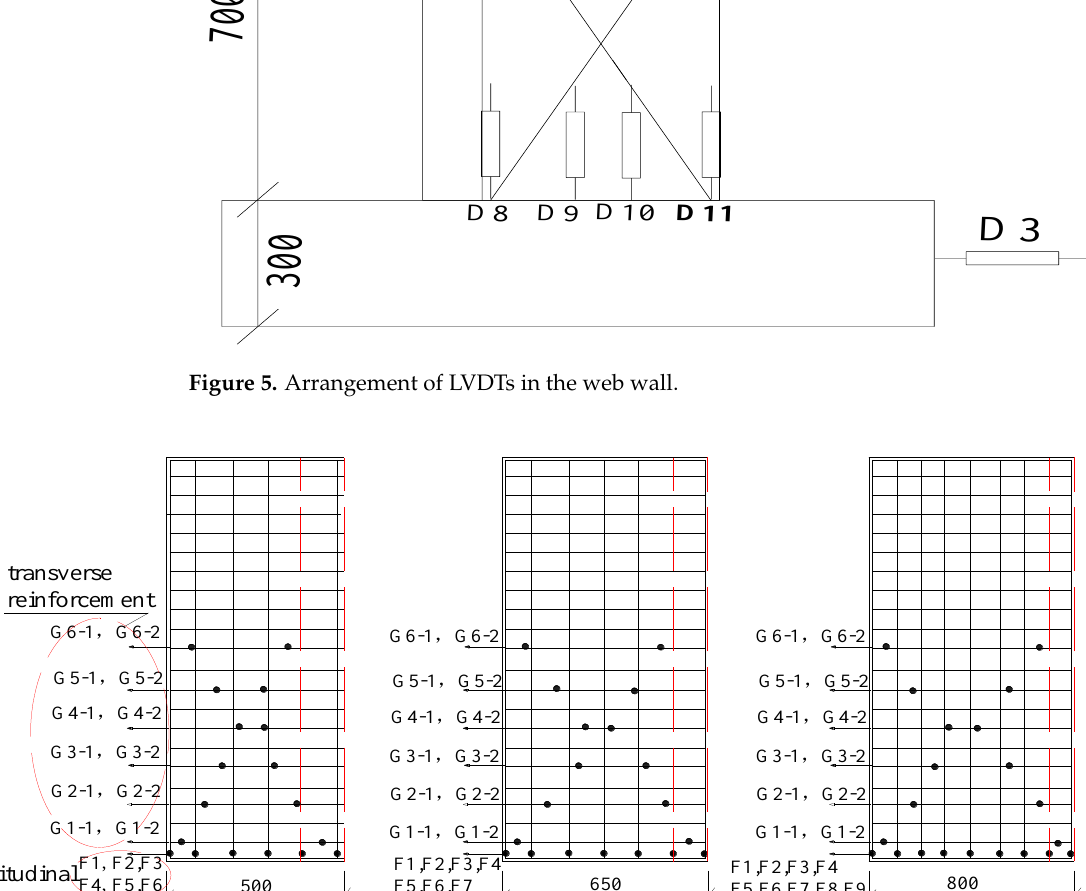
Figure 6. Arrangements of strain gauges of reinforcement in the web.